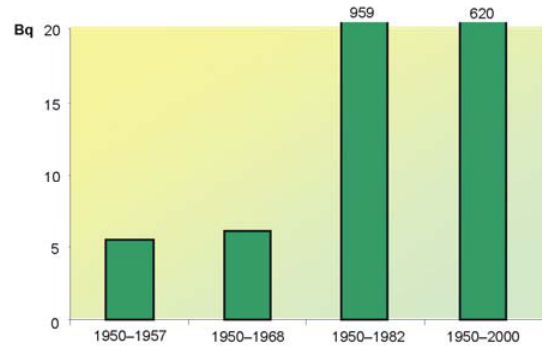
90 Sr activity in pinewood